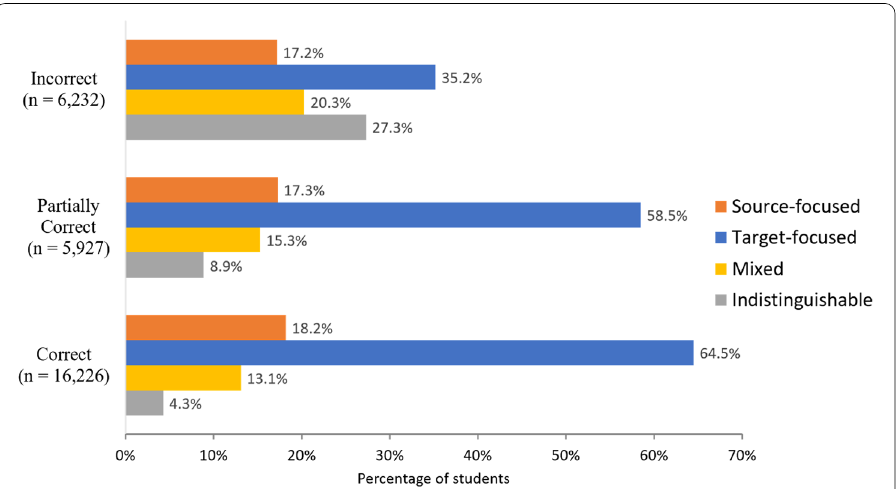
Fig. 5 Percentage of fourth‑grade students in each score group who applied a source‑focused, target‑focused, indistinguishable, or mixed strategy in response to the